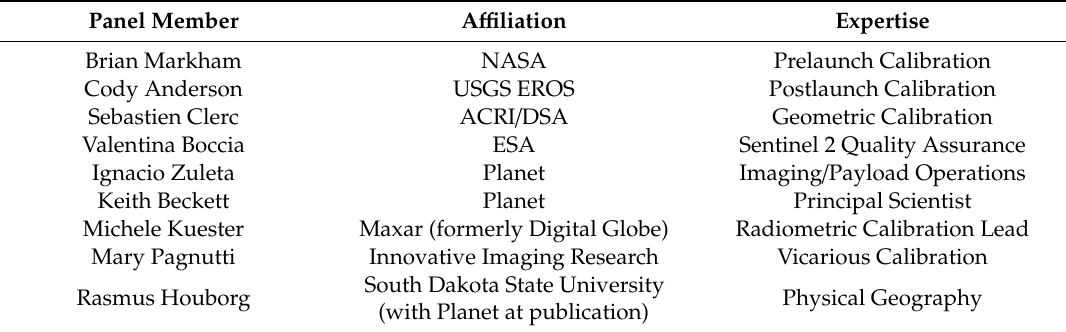
Table 1. List of 2018 ECCOE Workshop Panel Members. Panel Member A ffi liation